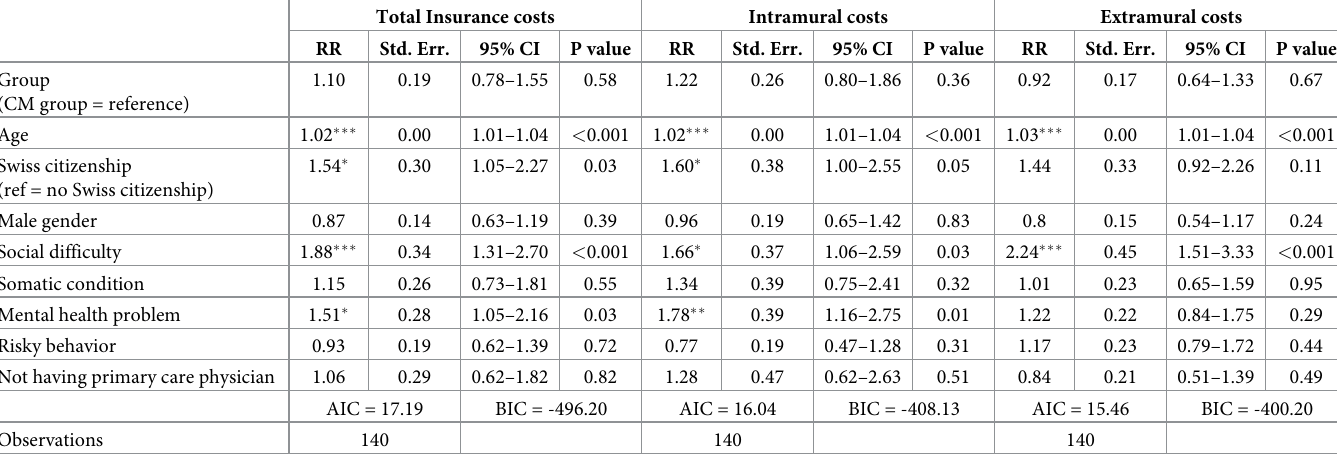
Table 5. Results of the gamma-log GLMs for total, intramural, and extramural costs evaluated from the insurance